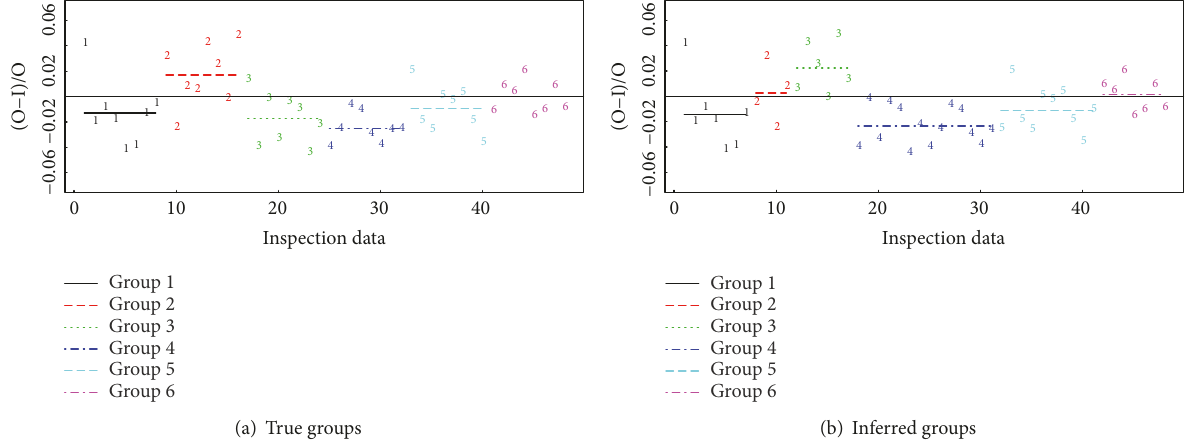
Figure 6: Example of change detection results using a sliding window and the MAD-based estimate of 𝛿 𝑅 . The simulated data had 𝑔 = 6 groups, each with 𝑛 = 8 observations, with 𝛿 𝑅 = .02, 𝛿 𝑆 = .01 .